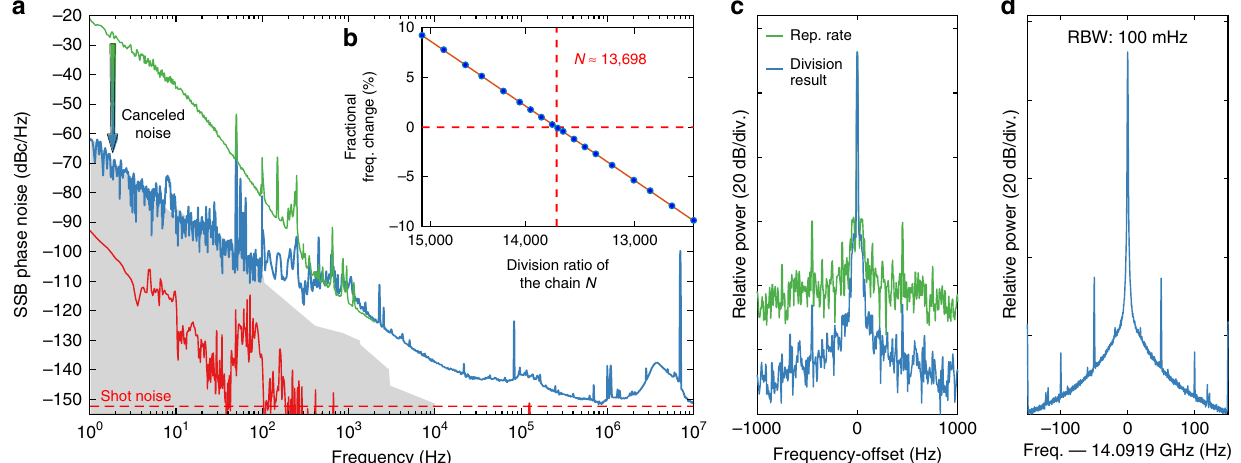
Fig. 3 Characterisation of the optical-to-microwave division signal. a Absolute single-sideband (SSB) phase noise of the 14.09 GHz signal generated by optical-to-microwave division of the USL via the Kerr comb transfer oscillator (blue) and obtained directly from the Kerr comb repetition rate (green) for comparison. The sensitivity limit of the phase noise analyser (3000 cross correlations applied at 1 Hz) is indicated by the grey shaded area. The red line is the limit inferred from the optical phase noise of the USL 71 , assuming an ideal noiseless division. b Precise determination of the optimal division factor N corresponding to the zero crossing of the linear fi t (solid line) of the measured relative frequency change of the generated RF signal for a small variation of the repetition rate (dots). c Comparison between the RF spectra of the Kerr comb repetition rate and the optical-to-microwave frequency division result. The resolution bandwidth (RBW) is 5 Hz. d RF spectrum of the frequency-divided output signal, the RBW is 100 mHz. The data was acquired with the IQ demodulation mode of the spectrum